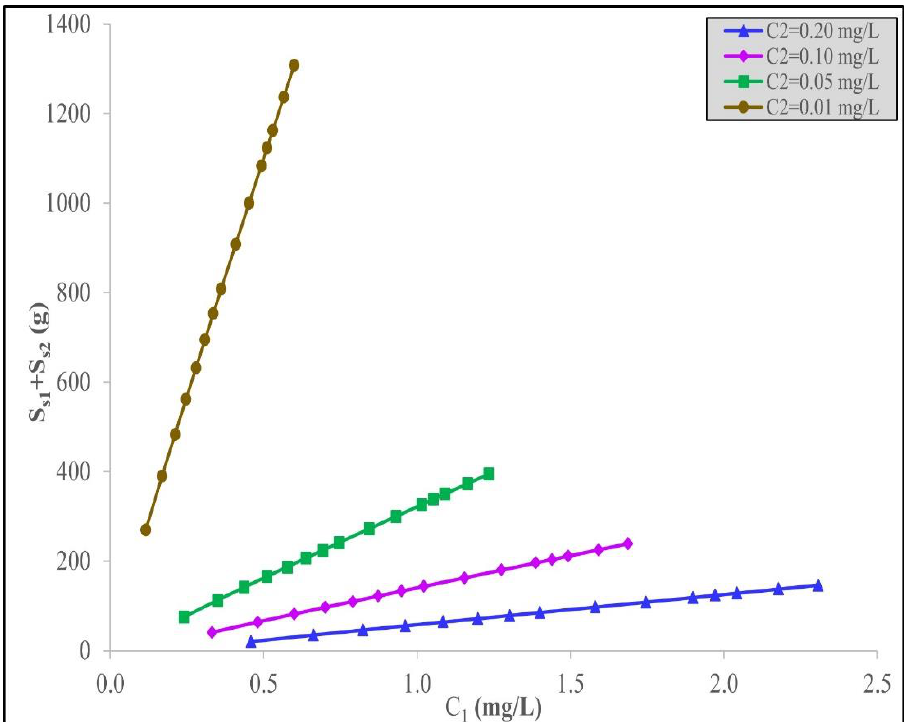
Figure 7. Minimum quantity of acid-treated date stone carbon, S 1 + S 2 , to remove IBU against the interstage IBU concentration, C 1 , using the Langmuir – Freundlich model for the set values of final IBU concentrations in the effluent, C 2 .